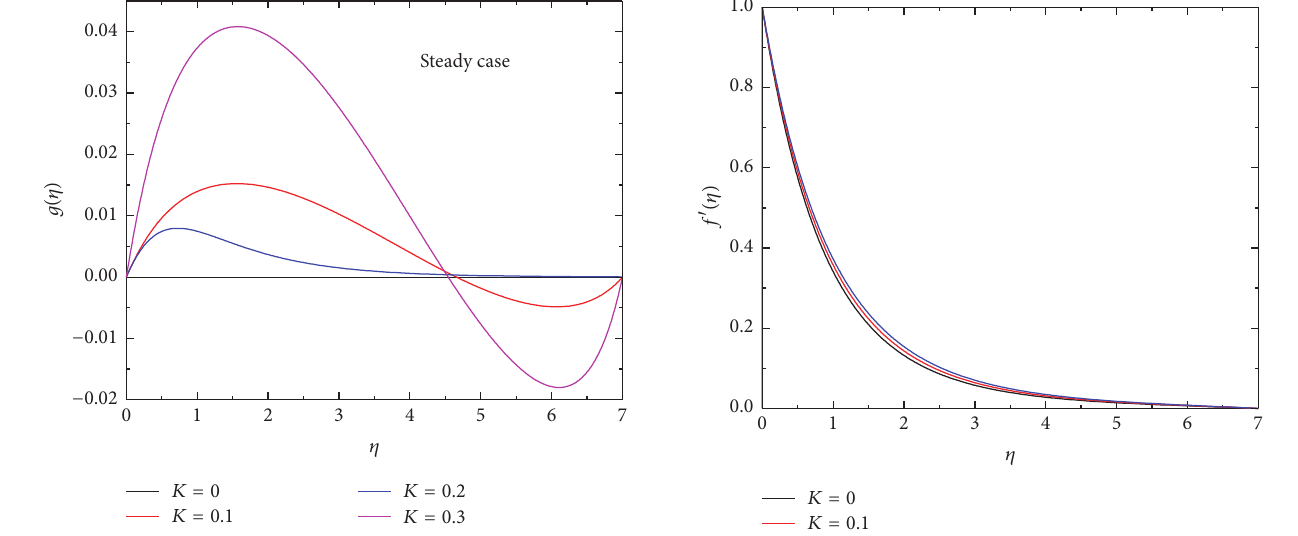
Figure 3: Microrotationprofiles forvarious values of 𝐾 when 𝐴 = 0 , 𝑅 = 0.5 , and 𝜉 = 0 .